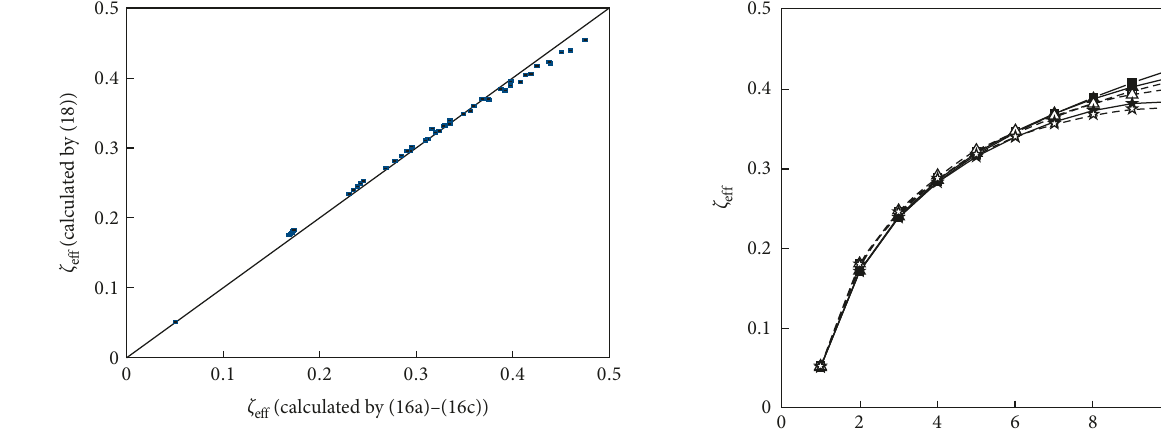
Figure 12: Comparison of the EVD ratio predicted by (18) and (16a)– (16c).